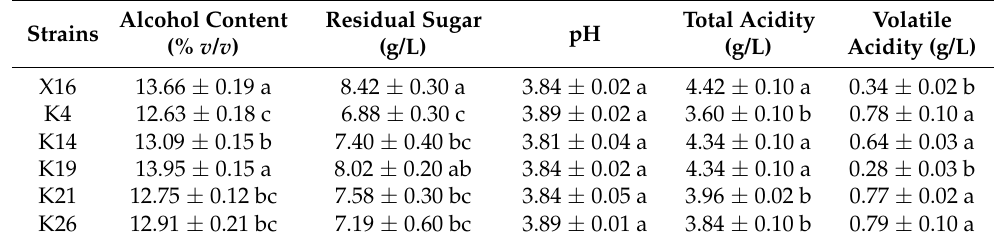
Note: Values in the same column with different lowercase letters are significantly different ( p <